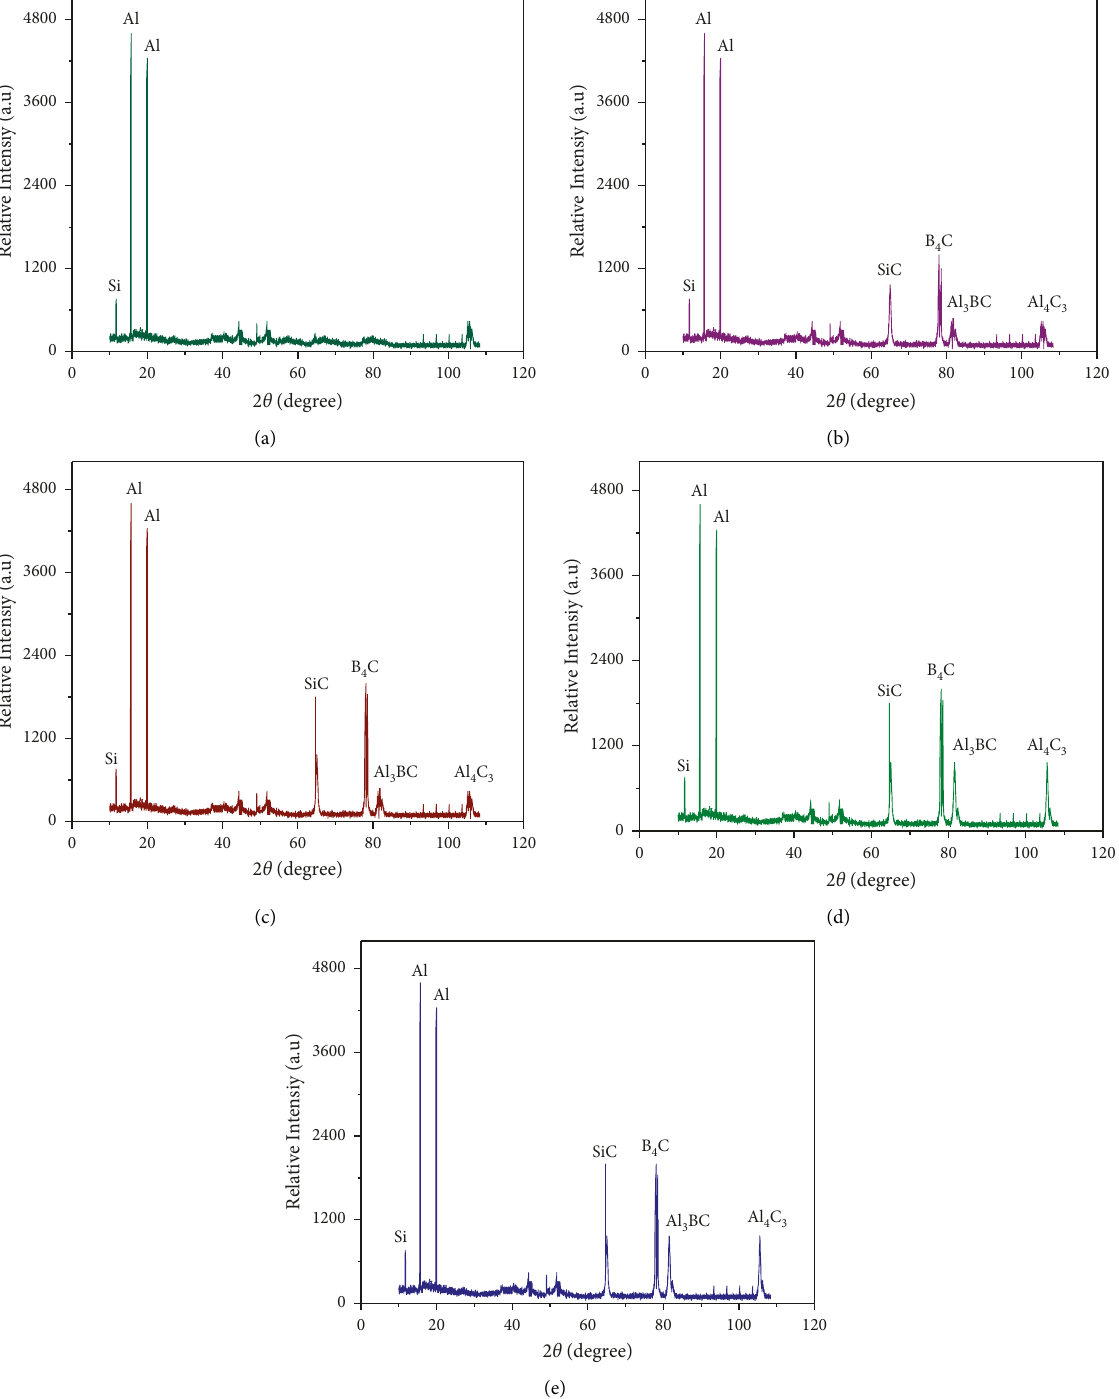
Figure 5: X-ray diffraction forms of (a) 0%, (b) 4%, (c) 8%, (d) 12%, and (e) 16% of (silicon carbide +boron carbide) strengthened hybridized